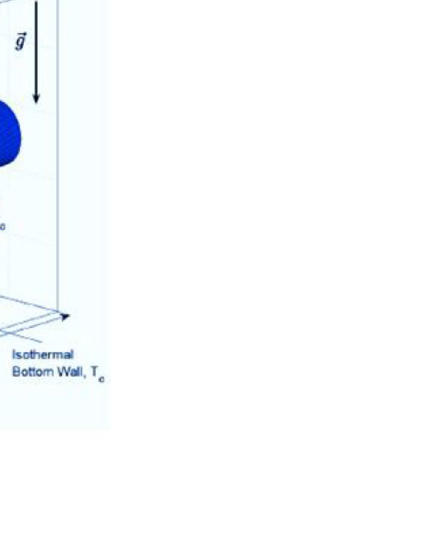
Figure 1. Physical model and problem